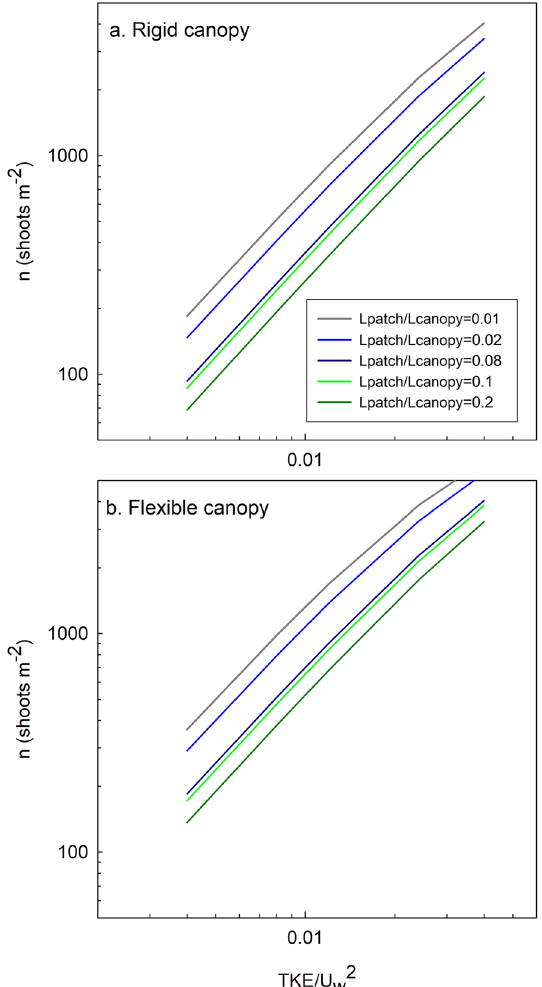
Figure 5. Number of shoots per m 2 ( n ) required to begin producing TKE versus TKE/U w 2 for different patch lengths and for ( a ) rigid and ( b ) flexible plant